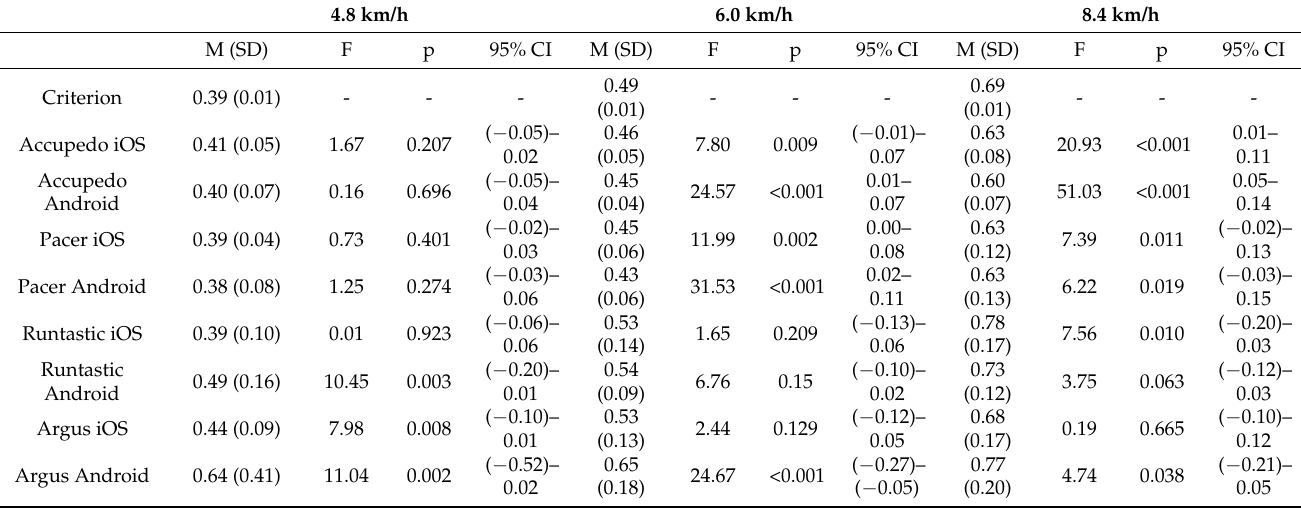
Table 4. Results of repeated measures ANOVA for distance (km) and comparison with criterion